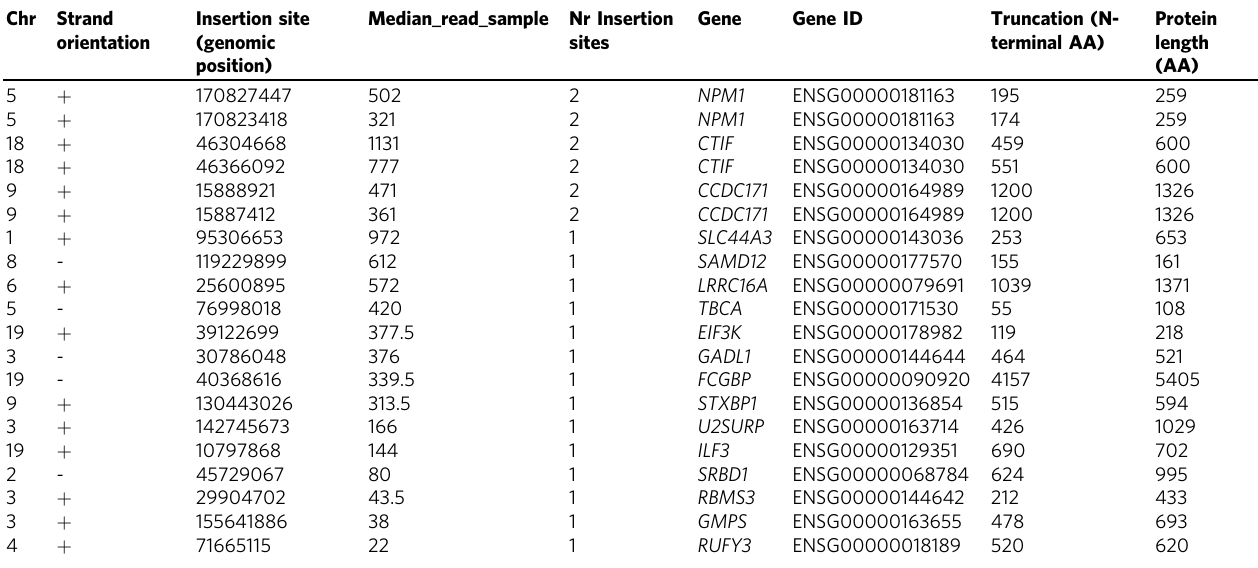
Table 1 A summary of the Tol2 integration sites identi fi ed in the PARylation